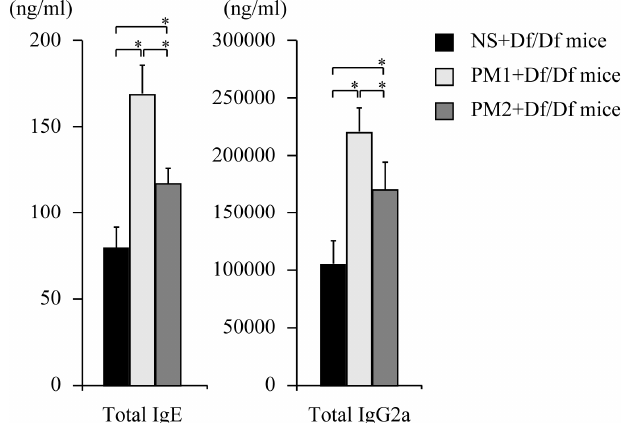
Figure 3. Total IgE and total IgG2a levels in serum. The levels of serum total IgE and total IgG2a were detected using enzyme immunoassays and presented as serum concentrations. Data for each group are expressed as mean ± standard deviation, and the results are from six mice per group. * p < 0.05.